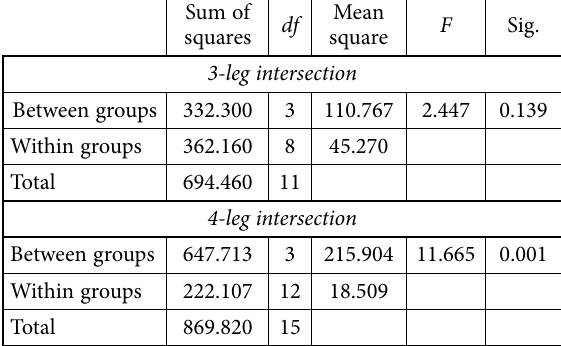
Sum of Mean squares square